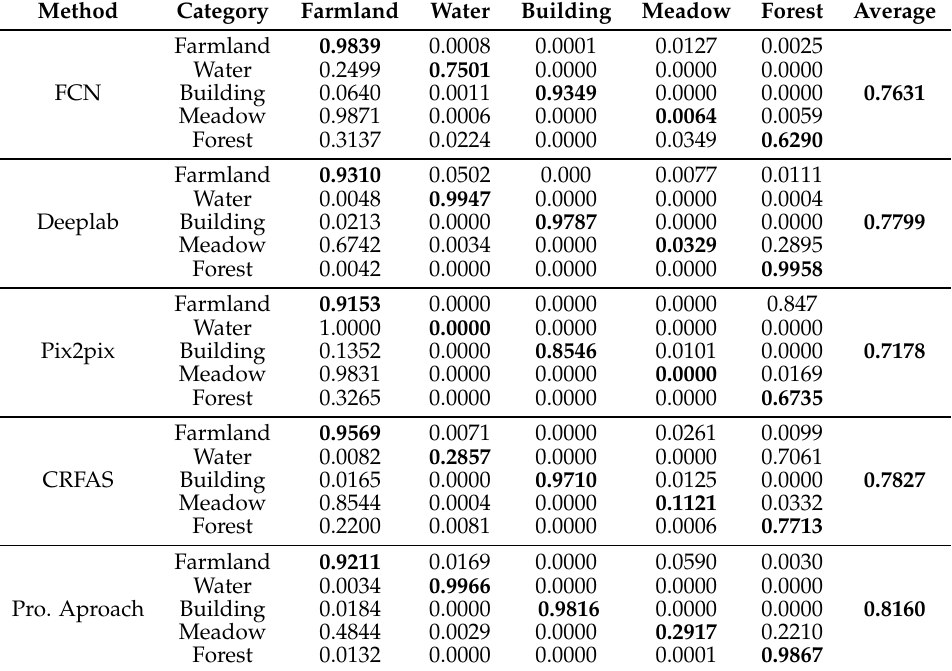
Table 2. Confusion matrix for GID-image1.